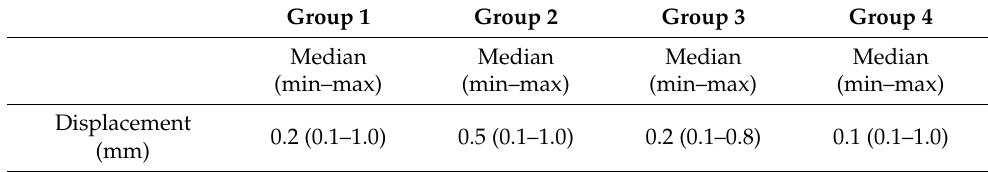
Table 3. Comparison of different post-and-core fabrication materials with the control